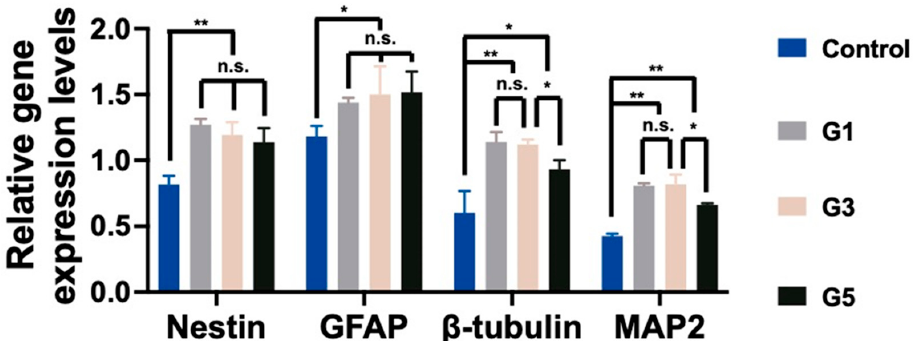
Figure 4. The stemness and differentiation of NSCs encapsulated in hydrogels. The gene expressions of neural-related genes, including nestin, GFAP, β -tubulin, and MAP2, were analyzed by RT-PCR after 14 days. The expression levels are represented by the relative ratios of gene expression nor- malized to that of GAPDH. * p < 0.05 and ** p < 0.01 between the indicated